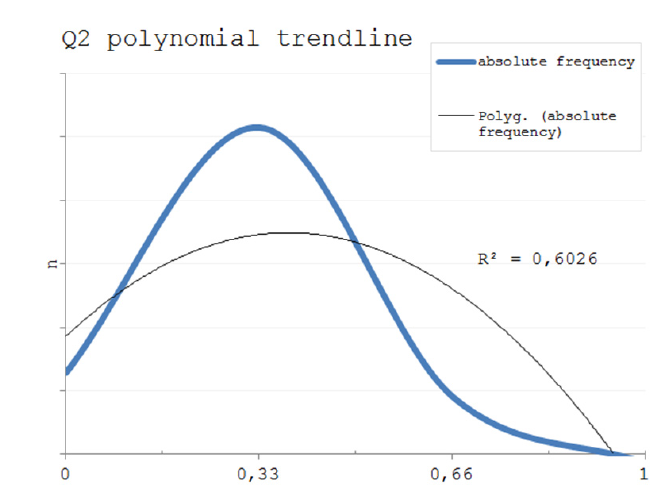
Fig. 2 - Q2 line chart with trend line. Source: authors